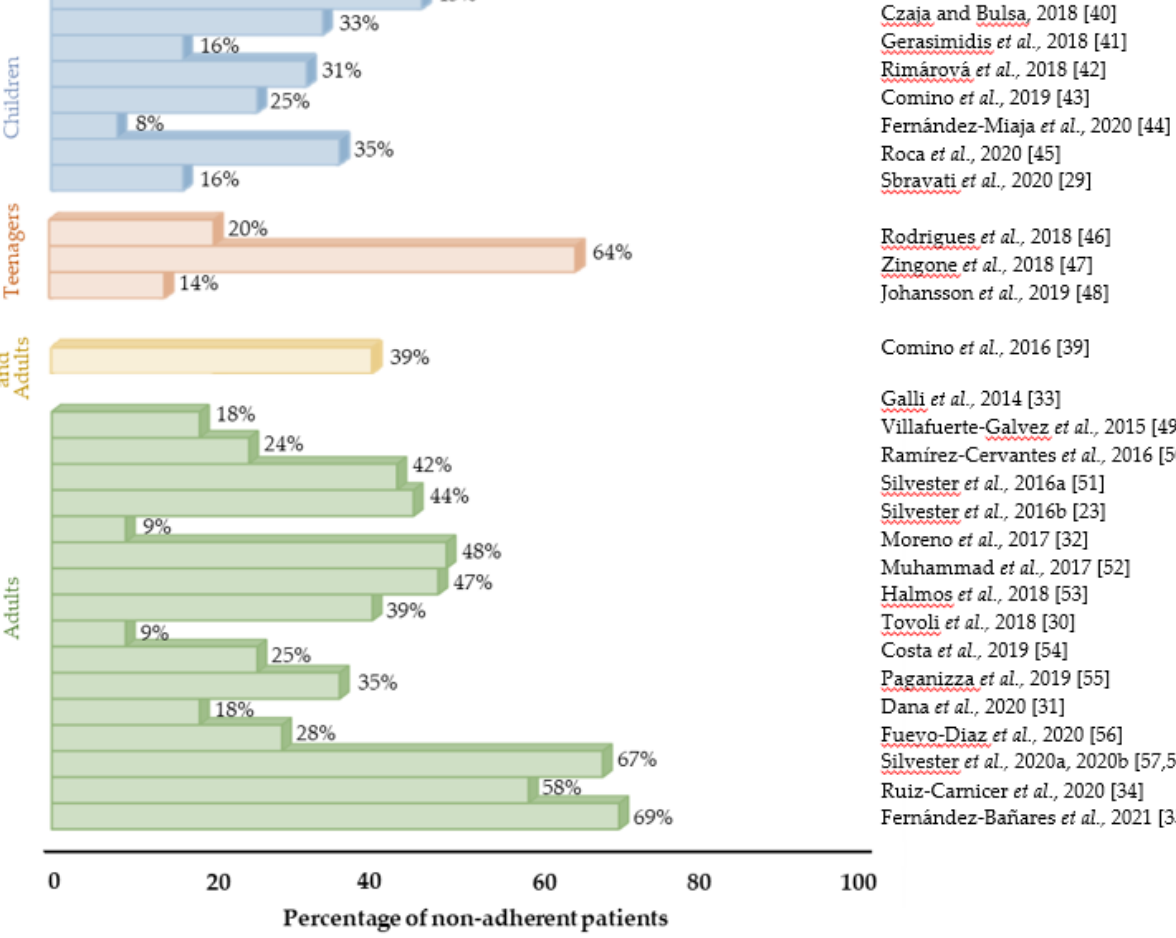
Figure 1. Studies reporting gluten exposure rates in CD patients on a supposed GFD. CD, celiac disease; GFD, gluten-free diet [23,29 – 58].